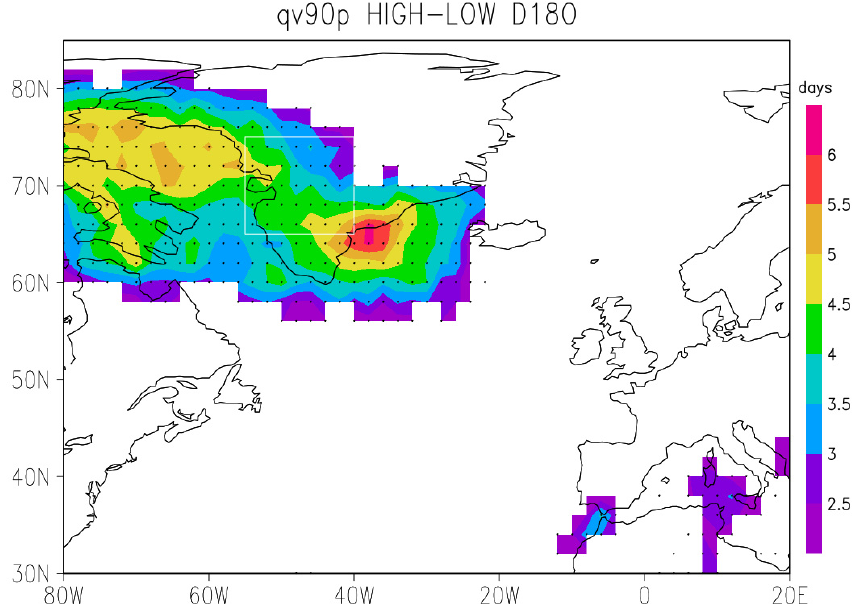
Figure 3. The difference between composite map of the qv90p index (see text for definition) for high and low ice core δ 18 O winters during 1851 to 1973. Only positive values higher than 2 days are shown. Regions where the difference is significant at the 90% level are dotted. Units: days. The rectangle box depicts index area (see text for details).